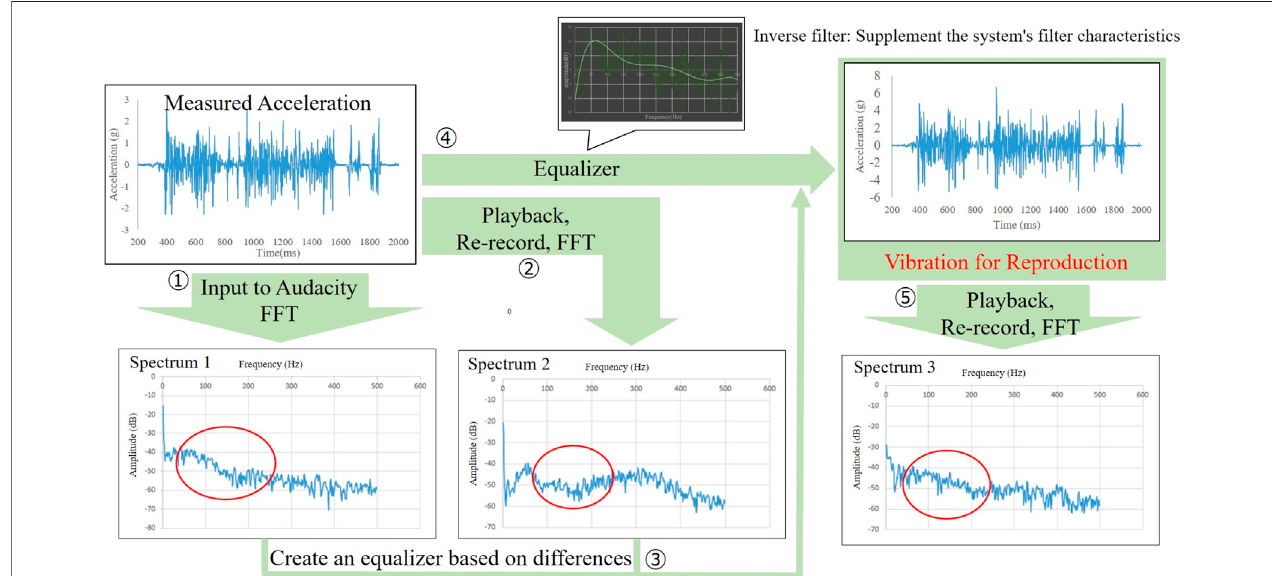
FIGURE 8 | The fl owchart for creating the inverse fi